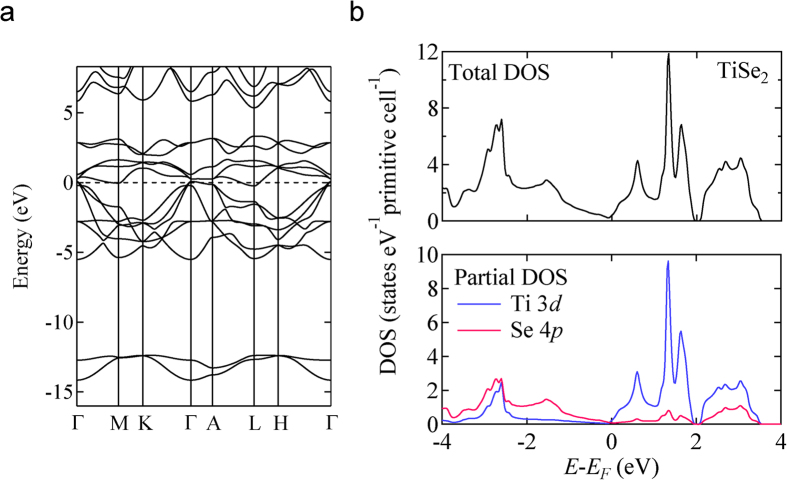
(a) Dispersion of the energy band of 1T-TiSe2. (b) Total and partial density of states (DOS) for 1T-TiSe2.